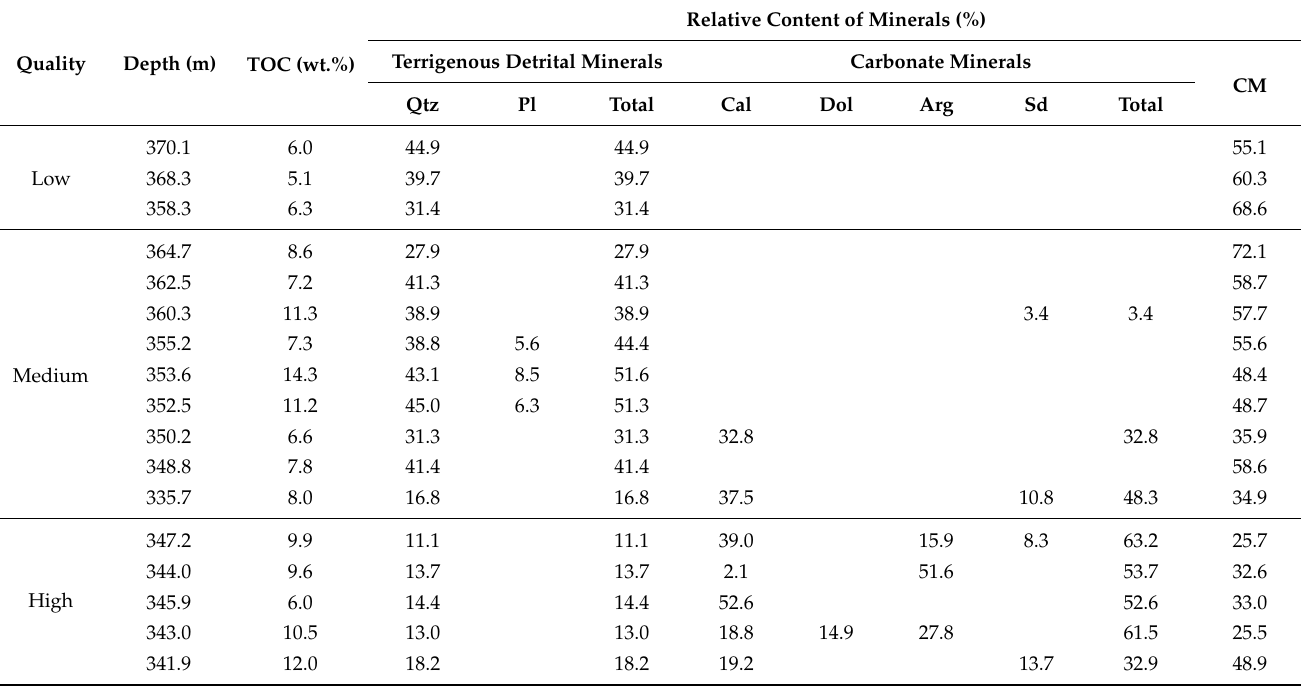
Table 2. Relative content of minerals in different quality oil shales in the Shale Member of the Middle Jurassic Shimengou Formation, Yuqia area, Qaidam Basin, based on XRD